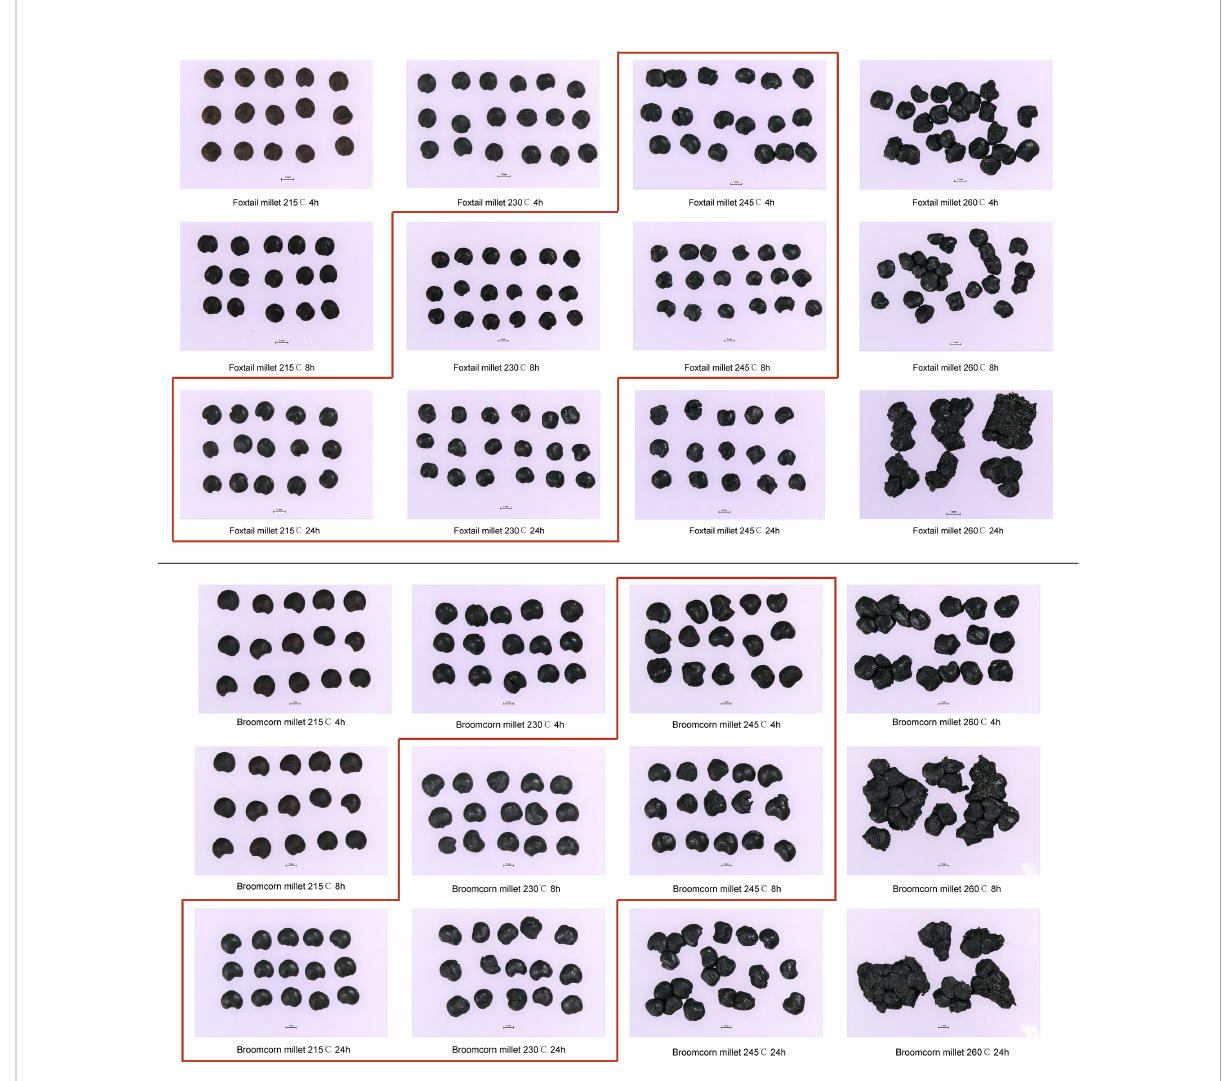
FIGURE 2 Charred foxtail (upper, Setaria italica ) and broomcorn millet (lower, Panicum miliaceum ) seeds under different charring conditions. The red box approximately delineates seeds comparable to well preserved archaeological